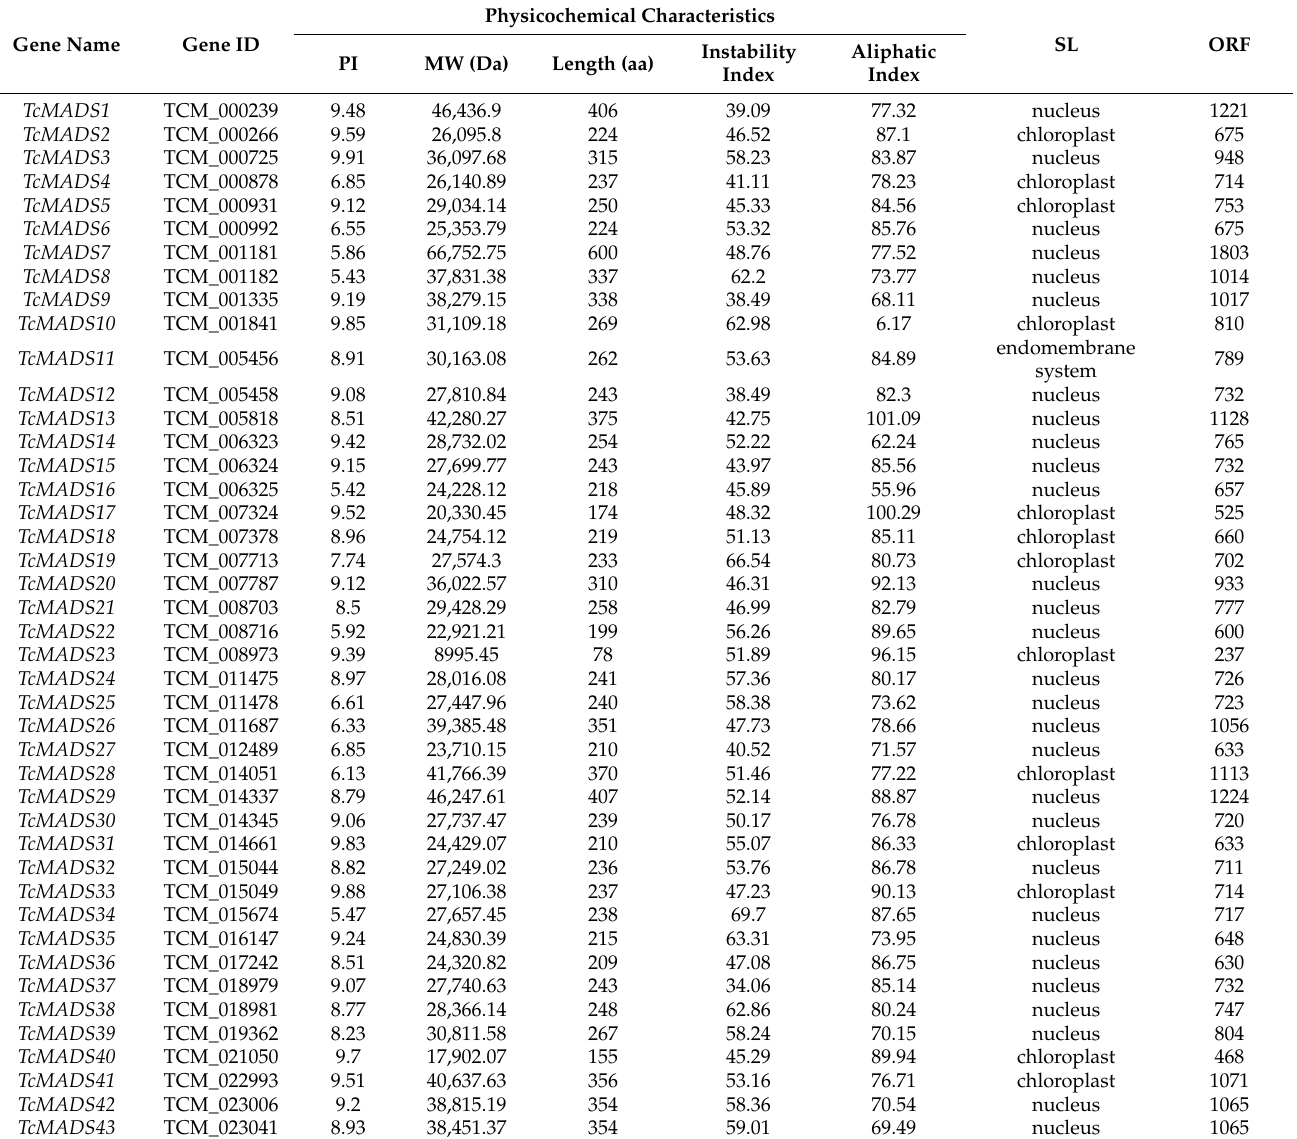
Table 1. Detailed information regarding MADS-box gene family in Theobroma cacao